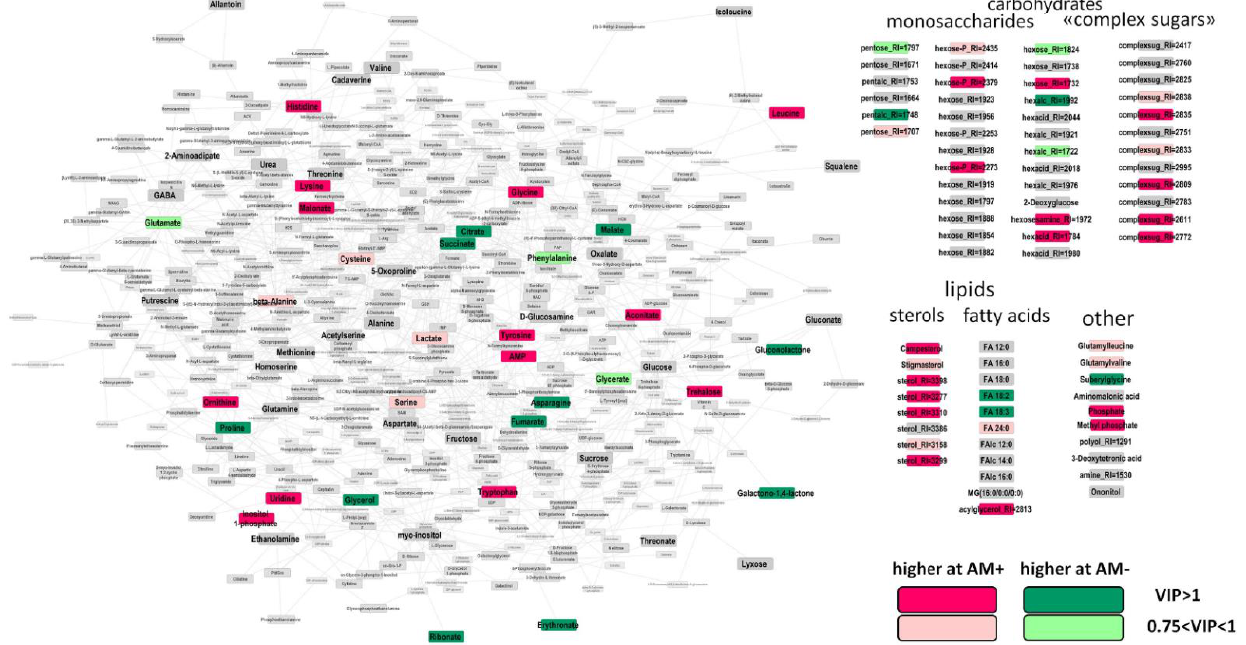
Figure 3. Visualization of differentially accumulated metabolites (DAMs) in response to mycorrhi- zation at 14 DAS as revealed through OPLS-DA. Nodes — metabolites; edges — reactions extracted from the KEGG database (see Section “Materials and Methods”).